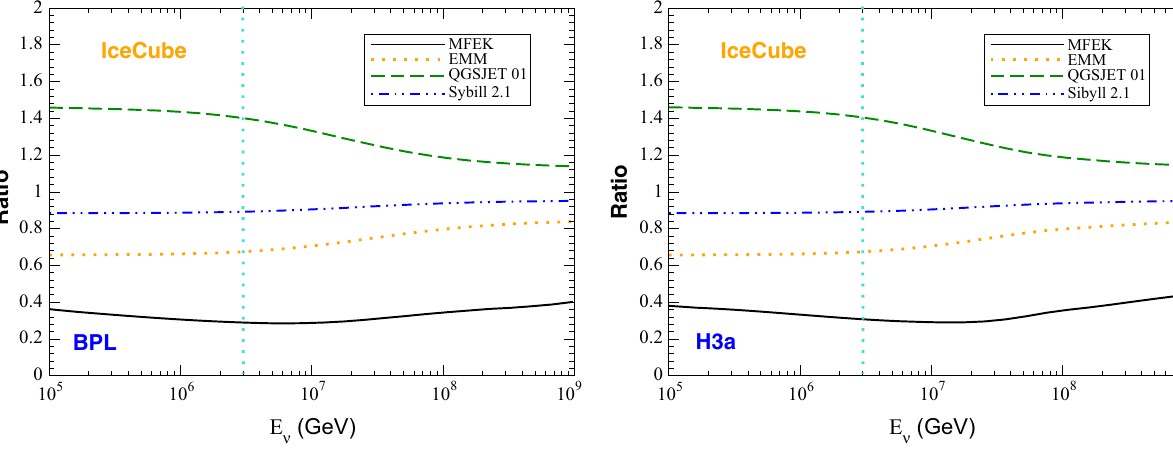
Fig. 3 Energy dependence for the ratio between the predictions of different models for the inelastic proton - Air cross section and the QGSJETII-03 one, calculated assuming the BPL (left) and H3a (right) models for the primary cosmic ray